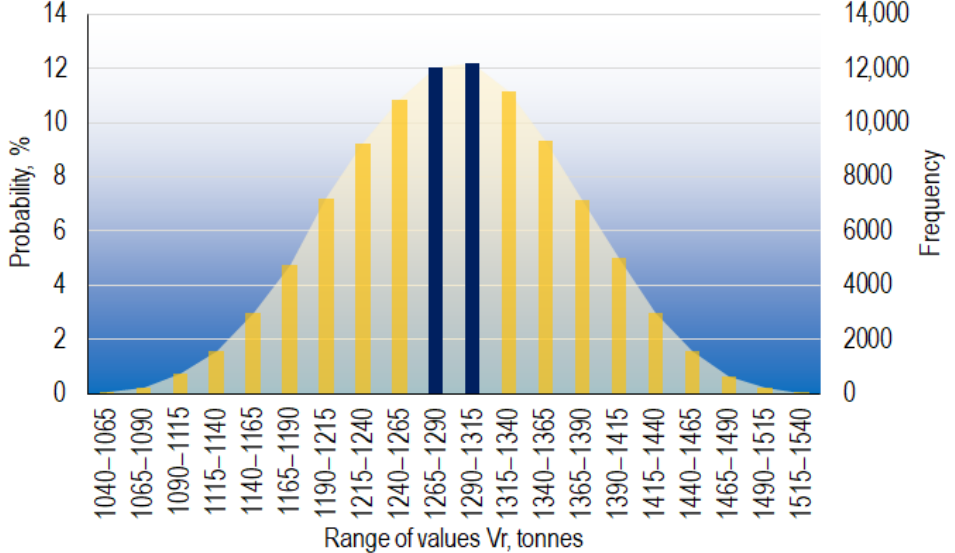
Figure 7. Search for the volume of drilled rock by the Monte Carlo method.